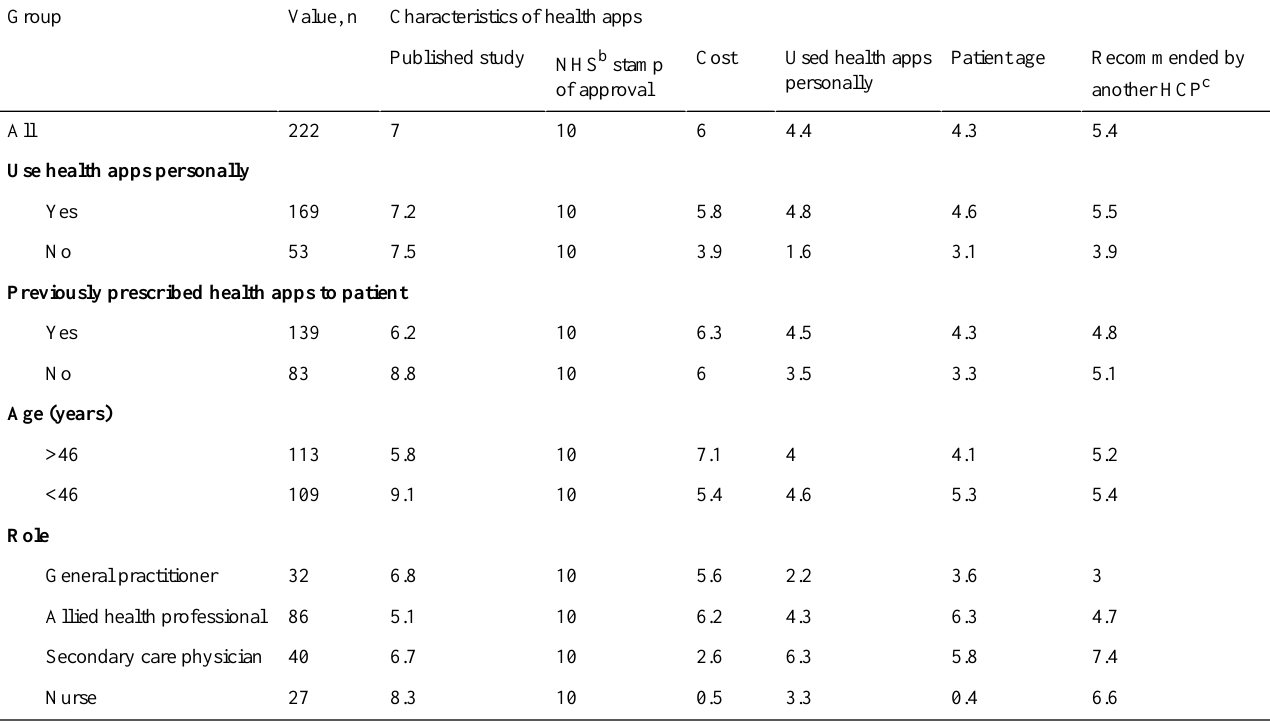
Table 4. Relative attribute importance a .